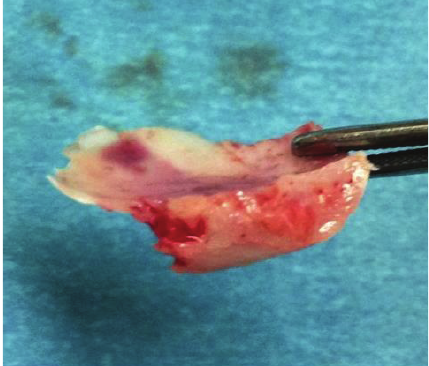
Figure 3: Intraoperative picture illustrating bone removed (anterior part is part of infraorbital